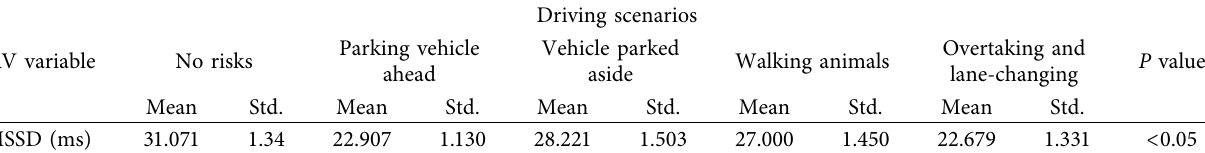
Table 5: Descriptive statistics (mean and standard deviations) for RMSSD measure in different risk scenarios. HRV